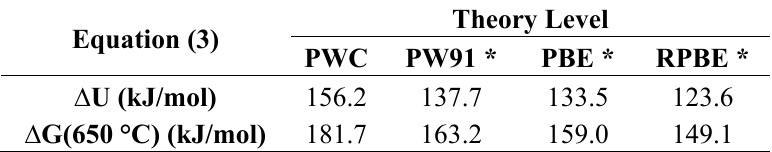
Table 2. Energy obtained after TS search and calculation of internal energy of activation of Equation (3). *Single point energy calculations on structures fully optimized at the PWC/DNP theory level. The temperature corrections used in the calculation of Δ G in those cases are the ones calculated at the PWC/DNP theory